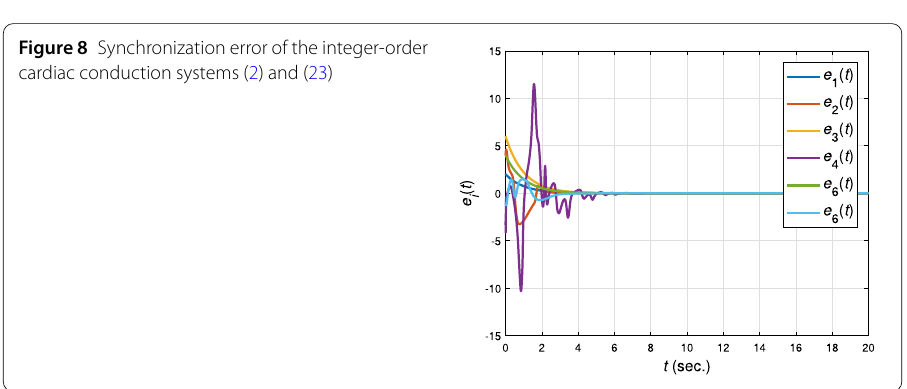
Figure 7 The synchronized state variables of the integer-order cardiac conduction systems (2) and (23)